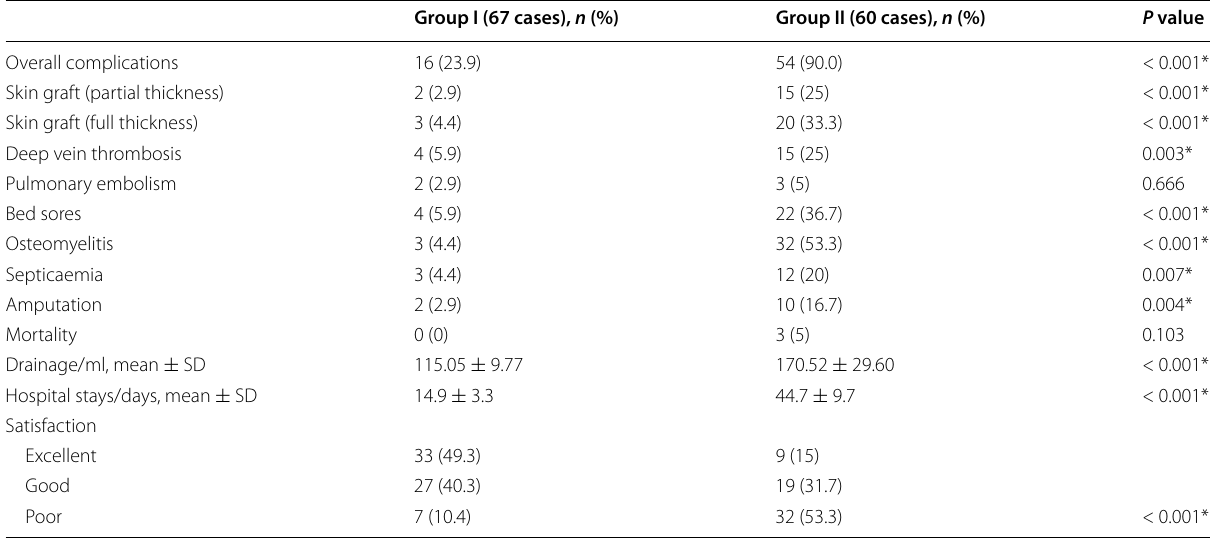
Table 4 Postoperative